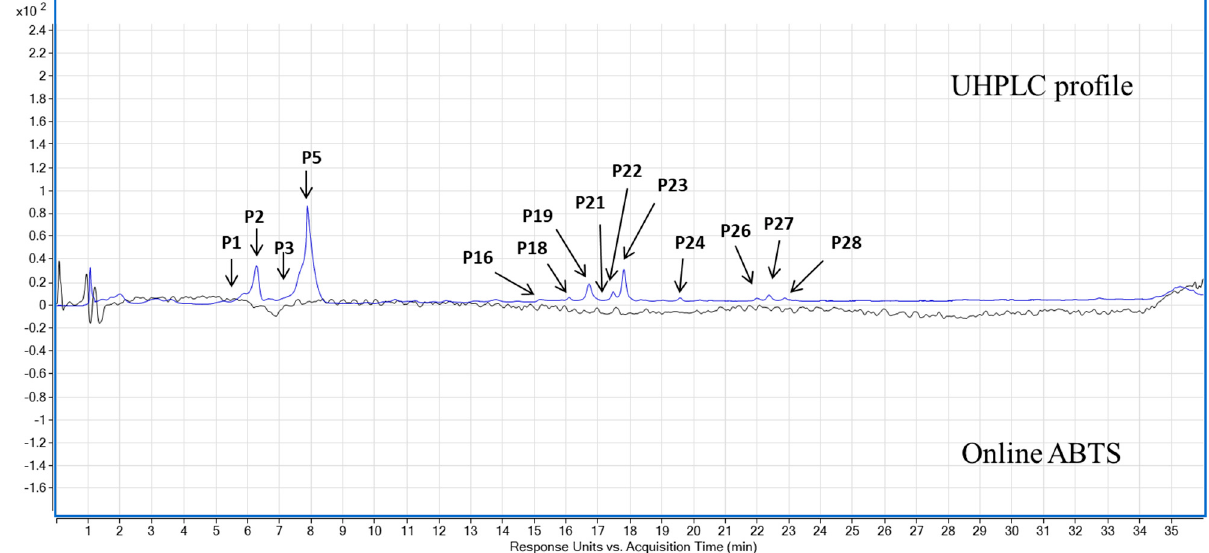
Figure 7. Ultra-high performance liquid chromatography (UHPLC) coupled with an online 2,2 ′ -azino-